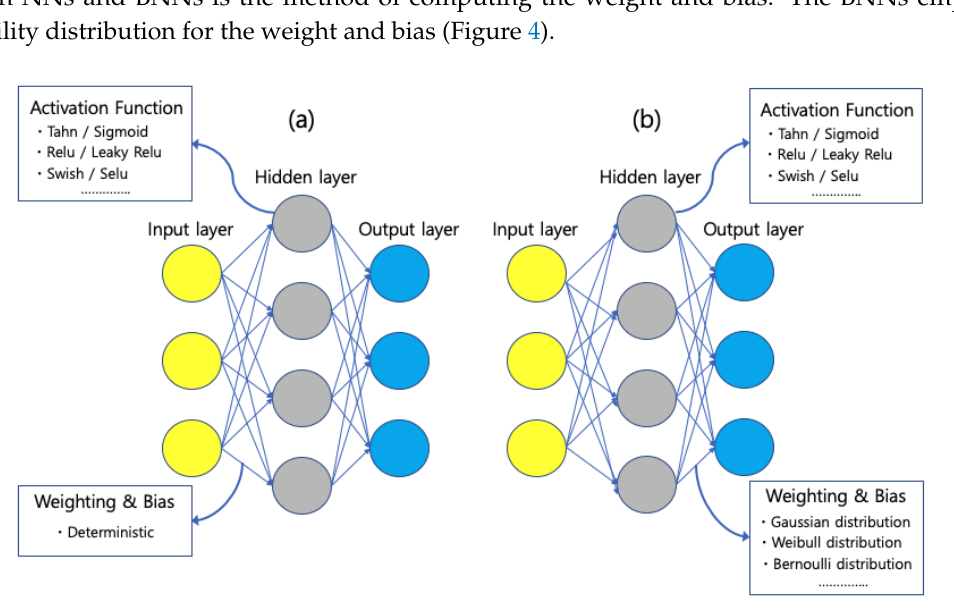
Figure 4. Architecture of ( a ) neural networks (NNs) and ( b ) Bayesian neural network